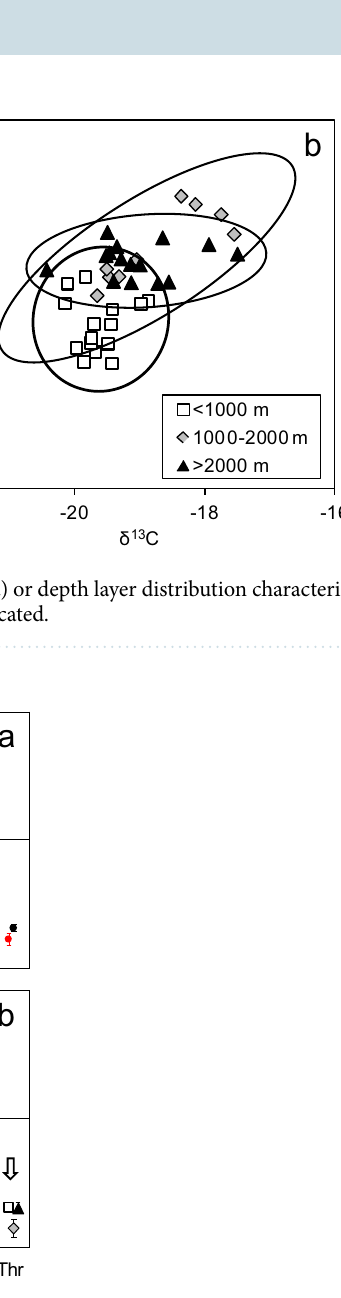
Figure 2. Mean (± s.e.) δ 15 N (‰) of trophic and source amino acids for ( a ) migrant (black dots) and non- migrant (red dots) species, and ( b ) for species grouped by depth layers. The arrows indicate significantly different means (Kruskal–Wallis test, P <